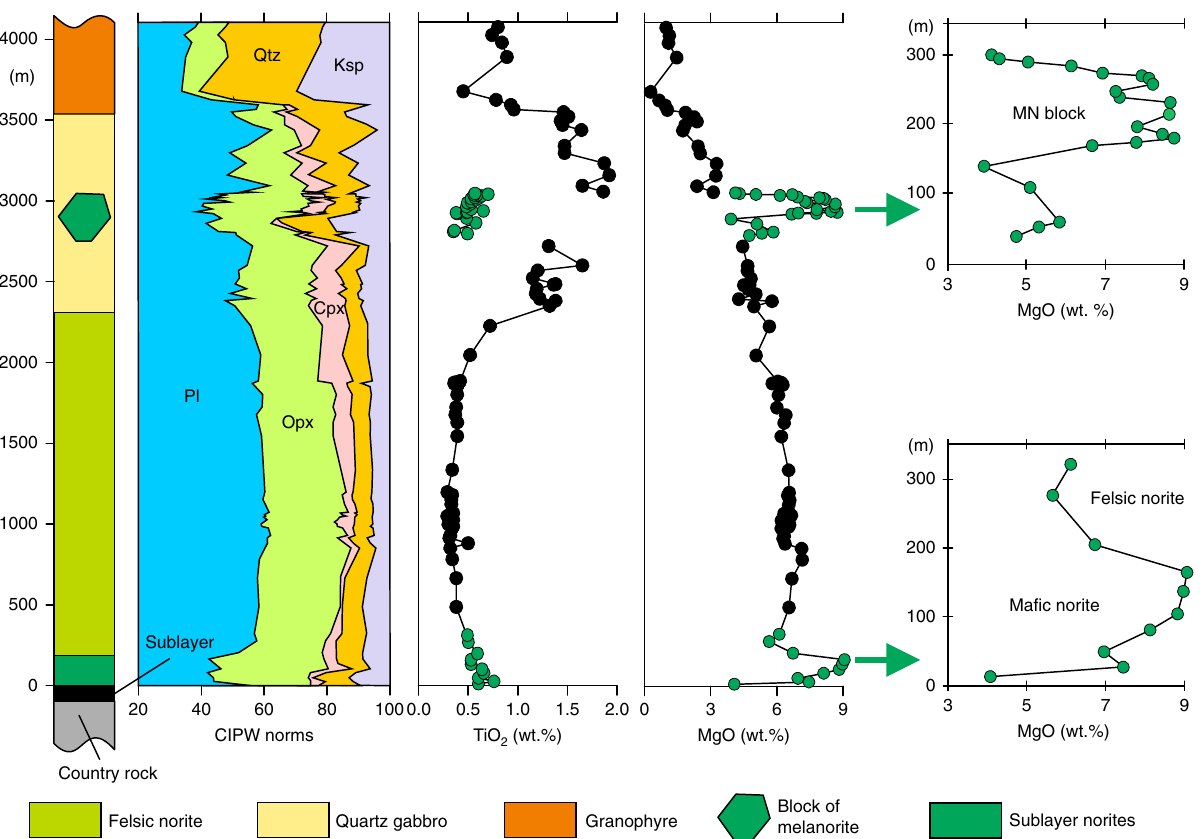
Fig. 5 Position of the largest melanorite body in the chemical stratigraphy of the SIC. Simpli fi ed section through the SIC along the Elm traverse, South Range, consists of felsic norites, quartz gabbro and granophyre. The body is located within the quartz gabbro (see Figs. 1 and 2c) and is distinguished by lower contents of whole-rock TiO 2 and higher MgO contents compared to the host quartz gabbro. The body is compositionally more primitive than felsic norites of the SIC, except for ma fi c norites that overly the Sublayer. Note that the body shows a compositional zonation in terms of MgO that is mirrored by that of ma fi c and felsic norites overlying the Sublayer (all indicated by green symbols). Original data are located in Supplementary Data